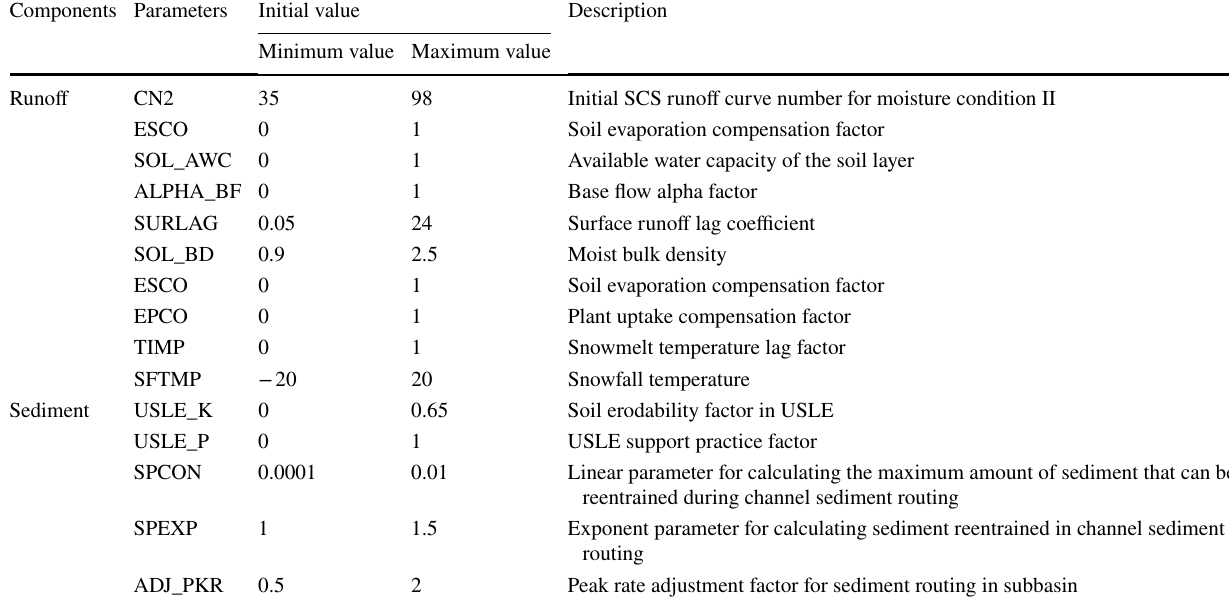
Table 3 Parameters for sensitivity analysis in ARCSWAT Components